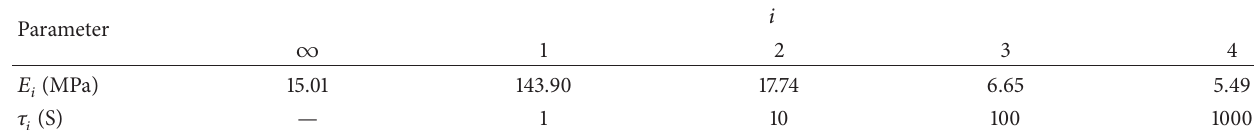
Table 5: Prony parameters of asphalt mortar.